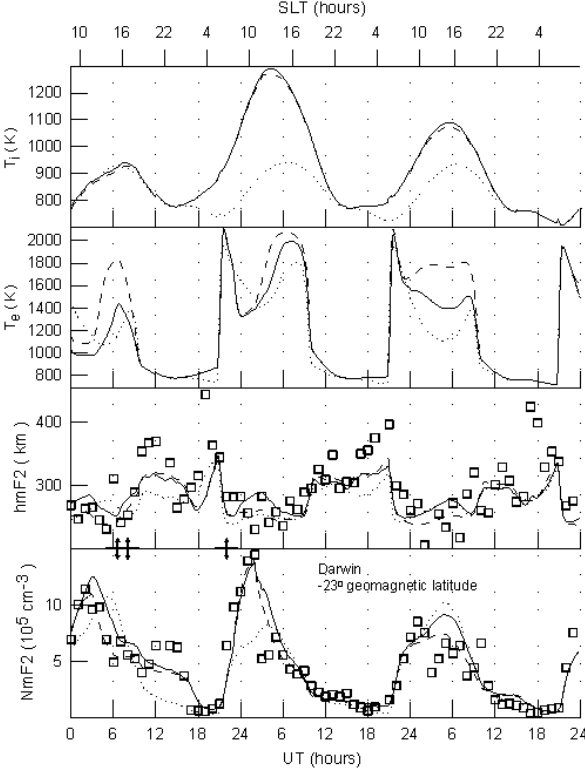
Fig. 5. From bottom to top, observed (squares) and calculated Fig. 4. Observed (squares) and calculated (lines) NmF 2 and hmF 2 (lines) of NmF 2, hmF 2, electron temperatures and O + ion tem- (two lower panels), and electron and O + ion temperatures (two up- peratures at the F 2-region main peak altitude above the Vanimo per panels) at the F 2-region main peak altitude above the Darwin ionosonde station during 25–27 August 1987. SLT is the solar local ionosonde station during 25–27 August 1987. SLT is the solar lo- time at the Vanimo ionosonde station. The start times of the sudden cal time at the Darwin ionosonde station. The results obtained from commencement (06:58 UT on 25 August), main phase (08:00 UT the model of the ionosphere and plasmasphere, using E eff based 3 on 25 August) and recovery phase (22:00 UT on 25 August) of the on the uncorrected zonal electric field, given by the solid lines in geomagnetic storm are indicated by the arrows. The curves are the Fig. 1, the NRLMSISE-00 neutral temperature and densities, and same as in Fig. the HWW90 wind as the input model parameters, are shown by dot- ted lines. Solid lines show the results obtained from the model of the ionosphere and plasmasphere using the combinations of E eff based 3 on the corrected zonal electric field given by crosses in Fig. 1, the corrected NRLMSISE-00 neutral temperature and densities, and the corrected meridional HWW90 wind. Dashed lines show the results from the model with the same corrections of the NRLMSISE-00 [O] and meridional HWW90 wind as for solid lines and when the value of E eff used in producing results shown by solid lines (based 3 on the corrected zonal electric field given by crosses in the bottom and middle panel of Fig. 1) was divided by a factor of 10 at all the studied geomagnetic latitudes during the studied time period. The start times of the sudden commencement (06:58 UT on 25 August), main phase (08:00 UT on 25 August) and recovery phase (22:00 UT on 25 August) of the geomagnetic storm are indicated by the arrows.